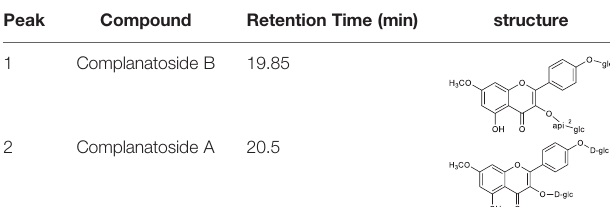
TABLE 1 | Compound of peak 1 and peak